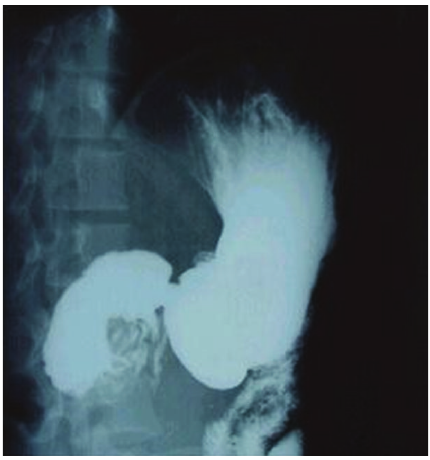
Figure 1: Upper GI series showing cut-off area between the second and third parts of duodenum.